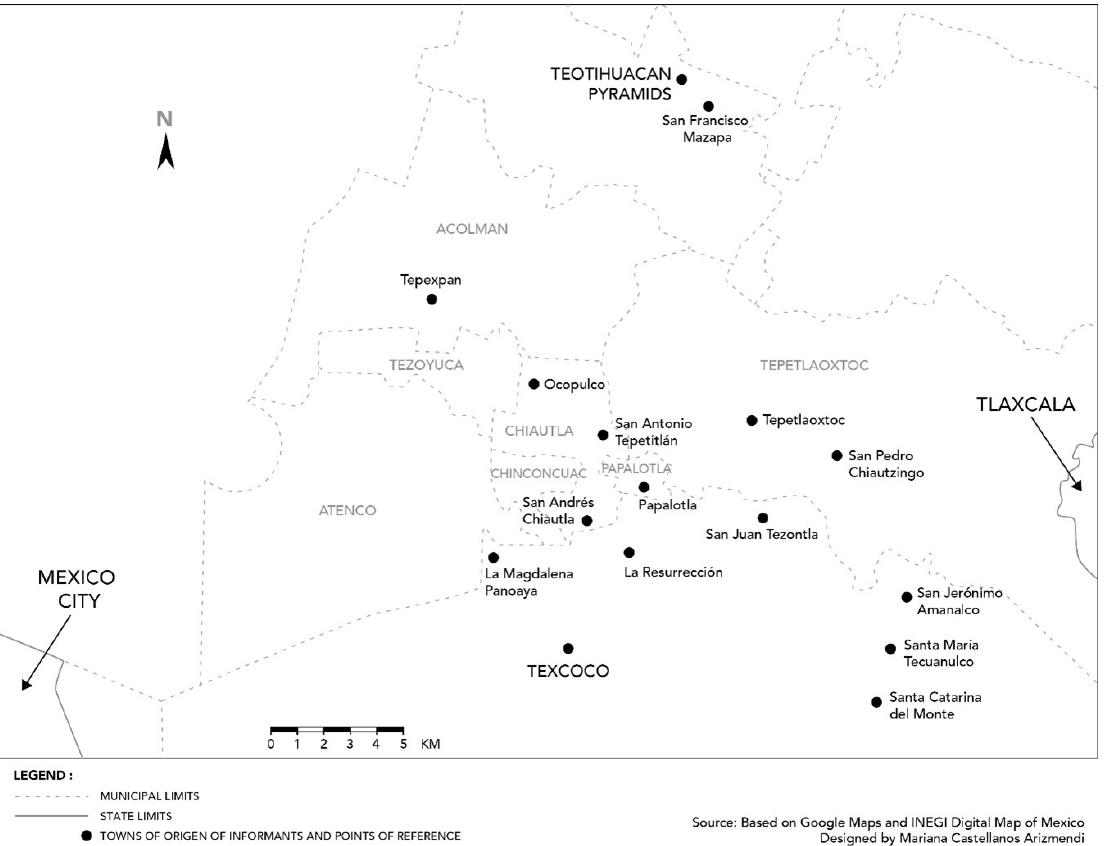
Figure 1 Towns of origin of informants interviewed for this